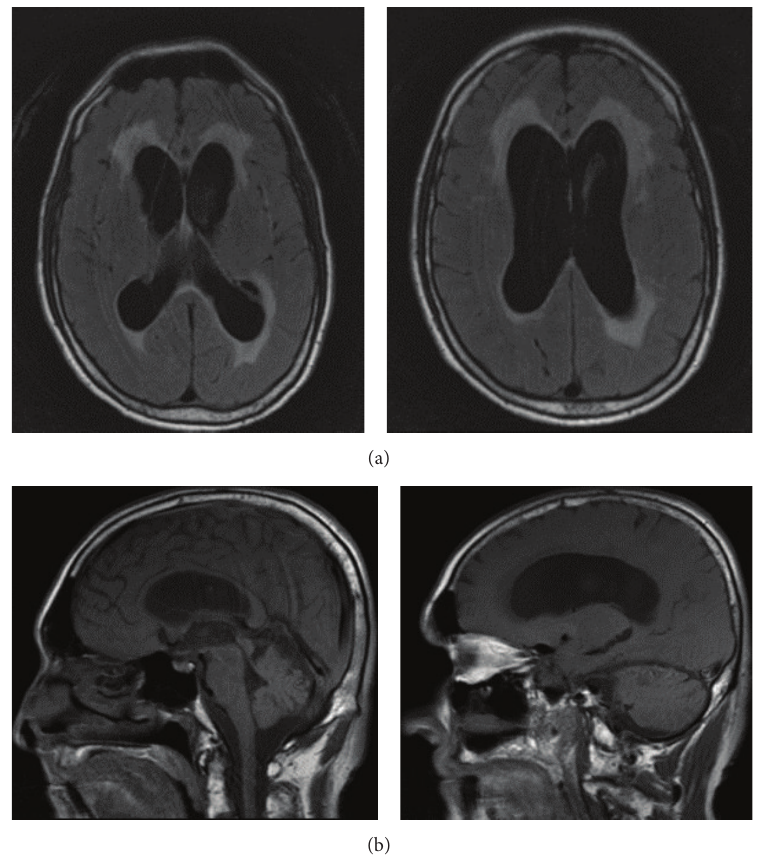
Figure 1: MRI FLAIR axial (a) and sagittal (b) notable for communicating